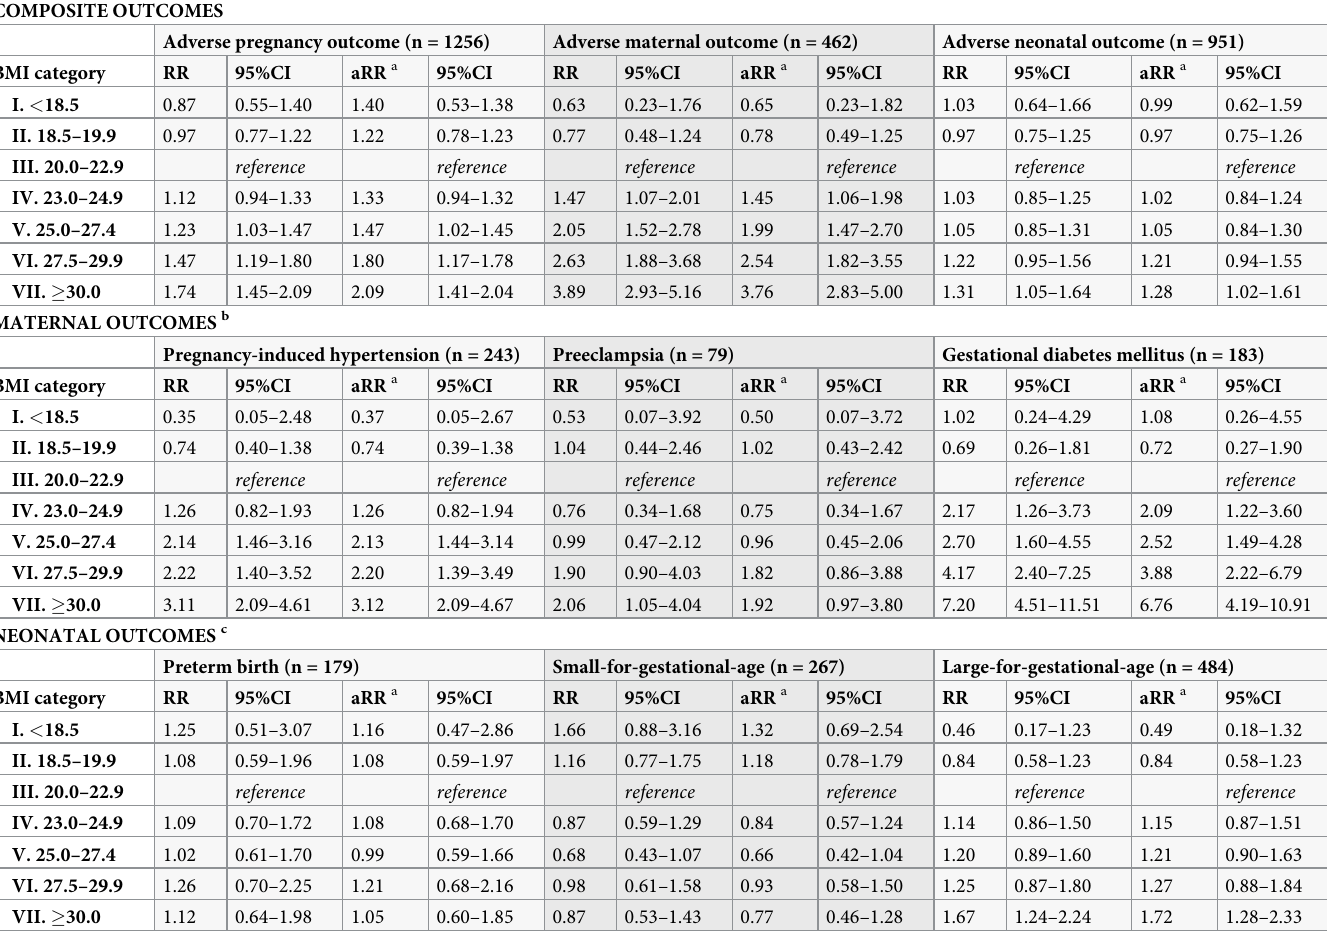
Table 3. Pregnancy outcomes per maternal prepregnancy BMI category (n = 3671). COMPOSITE